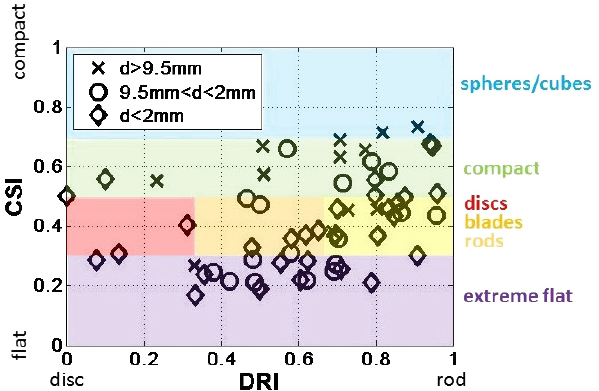
Figure 4. Sample measurements of particle shape expressed as disc-rod index (DRI) and Corey Shape Index (CSI). Description and schematic modified after Illenberger